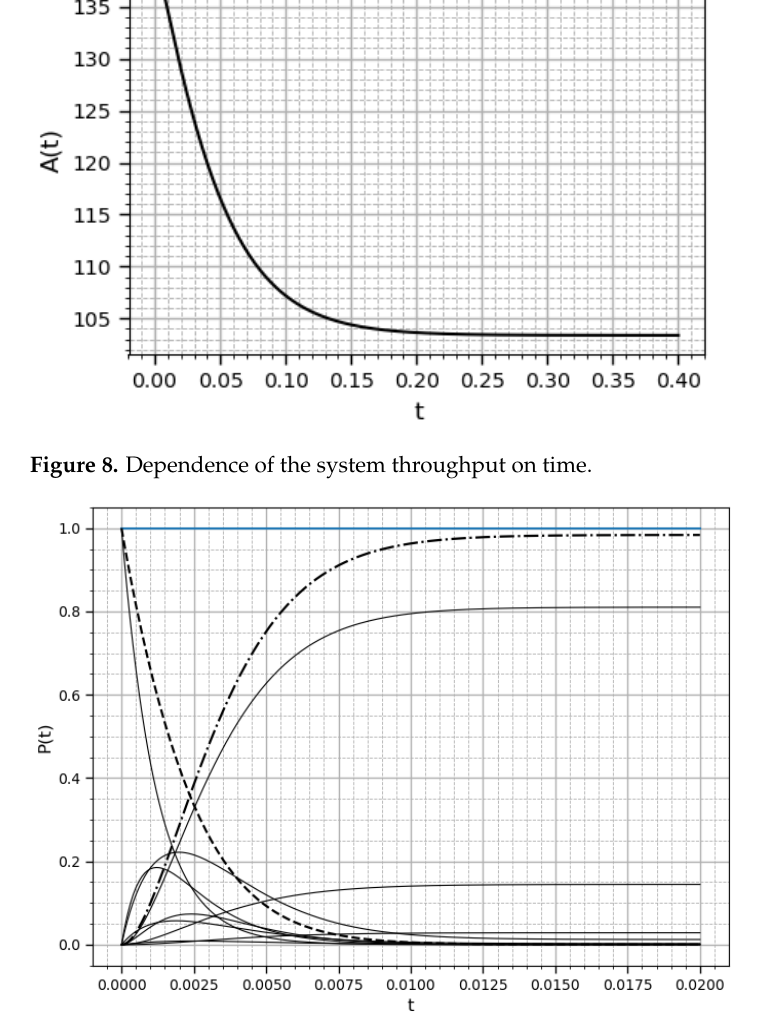
Figure 9. Dependencies of the probabilities on the time. Dashed and dotted line—the probability of losses; dashed line—the servicing device is idle, the buffer is